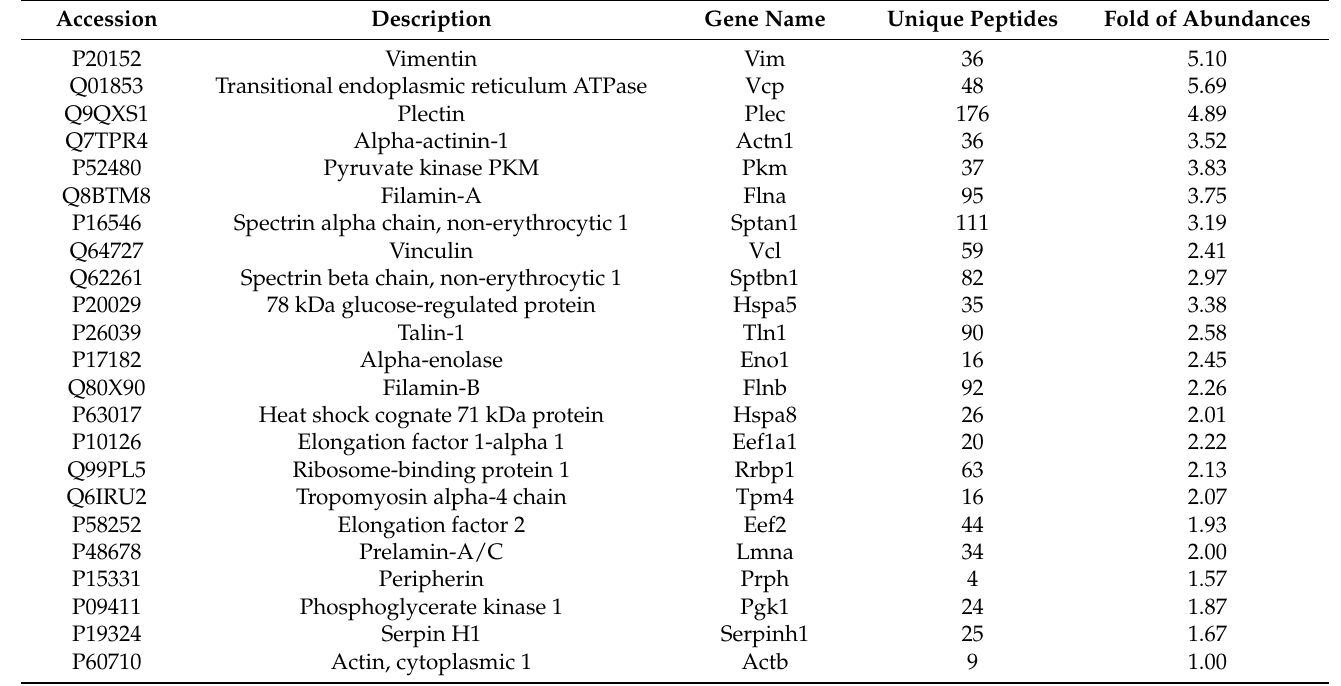
Table 1. The abundant exosomal proteins that exhibited at least 1.5-fold upregulation than the cytoplasmic actin protein in the exosomes secreted by ADSCs following in FK506 treatment.